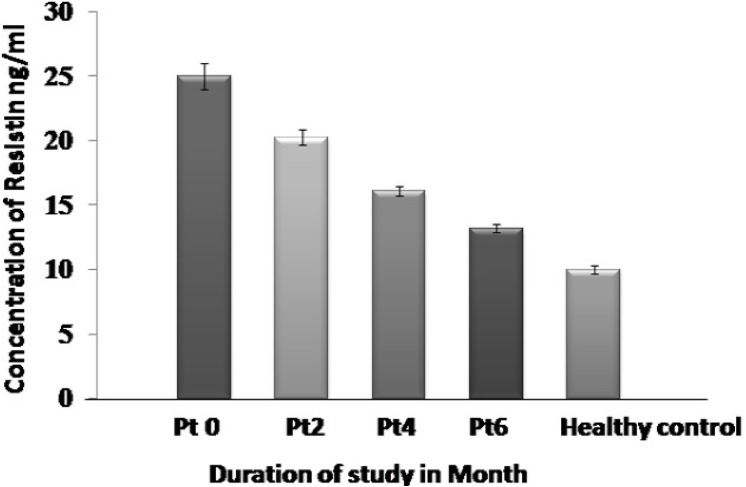
Correlation of Serum resistin levels between different groups of Mtb infected patients.Resistin decreases significantly during anti-TB therapy. Cut off value (13.0ng/ml) was calculated as the mean resistin values obtained in healthy control plus 2 standard deviations of the mean.